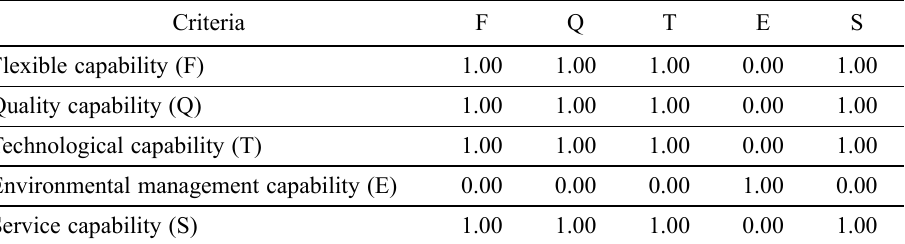
Table 5. Matrix ( R ) of all criteria